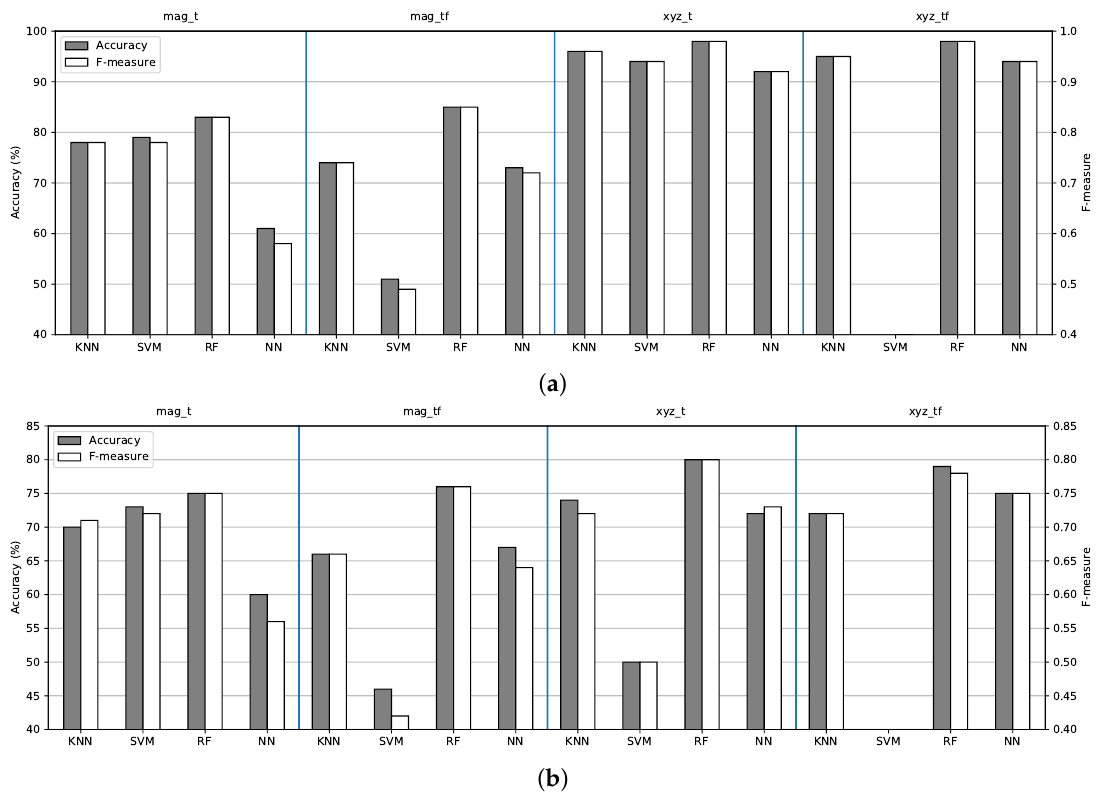
Figure 6. Classifiers performance. ( a ) Ten-fold cross-validation; ( b ) LOSO cross-validation. Because the number of classes in the dataset was perfectly balanced, we analyzed only the accuracy score. The best results were obtained from the RF classifier for both cross-validation methods. For the 10-fold cross-validation method, extracting features from the magnitude vector in the time domain ( mag_t ), the classifier achieved an accu- racy of 83% (+/ − 1.53 std); extracting features from the magnitude vector in both the time and frequency domains ( mag_tf ), the obtained accuracy was 85% (+/ − 1.94 std); extracting features from the raw triaxial signal in time domain ( xyz_t ), an accuracy of 98% (+/ − 1.06 std) was achieved; and extracting features from the raw triaxial signal in both the time and frequency domains ( xyz_tf ), the classifier obtained an accuracy of 98% (+/ − 0.79 std). On the other hand, using the LOSO cross-validation method, extracting features from the magnitude vector in the time domain ( mag_t ), the classifier achieved an accuracy of 75% (+/ − 7.45 std); extracting features from the magnitude vector in both the time and frequency domains ( mag_tf ), an accuracy of 76% (+/ − 7.70 std) was achieved; extracting features from the raw triaxial signal in the time domain ( xyz_t ), an accuracy of 80% (+/ − 11.30 std) was achieved; and extracting features from the raw triaxial signal in both the time and frequency domains ( xyz_tf ), the classifier obtained an accuracy of 79% (+/ − 11.80 std). All classifiers obtained worse accuracy scores from the